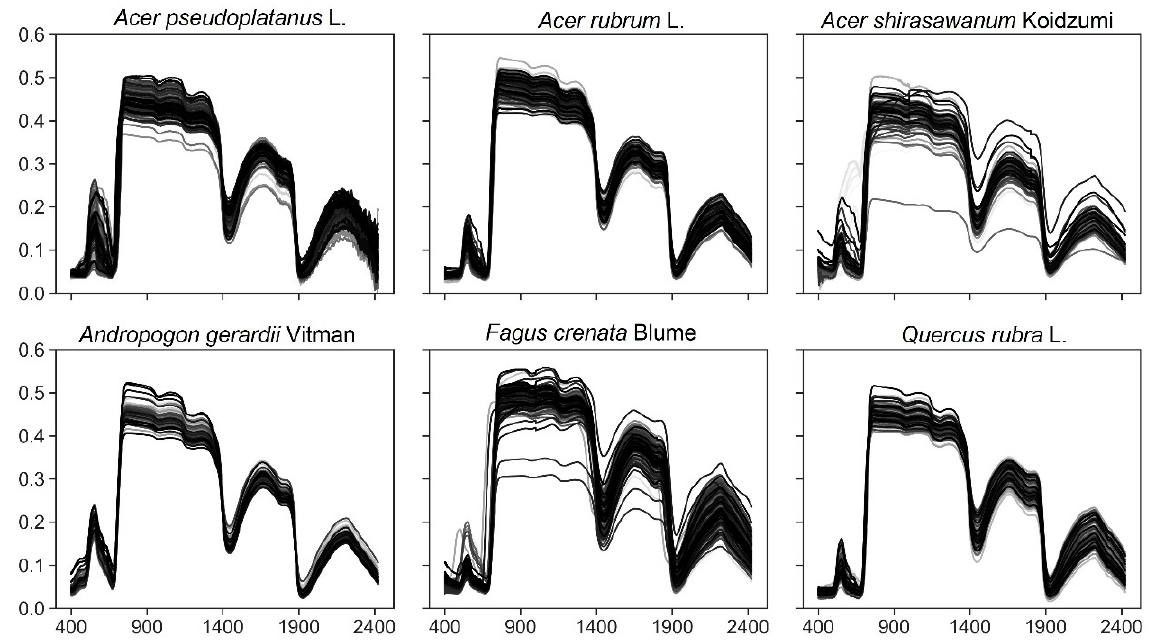
Figure 2. Training and validation of leaf spectra of selected species.